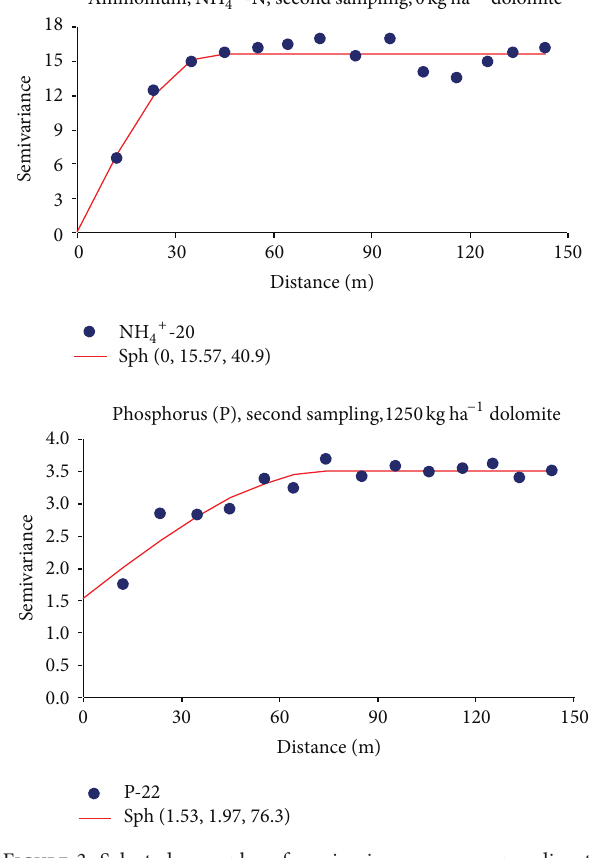
Figure 3: Selected examples of semivariograms corresponding to experimental data sets without nugget effect and with the highest nugget effect